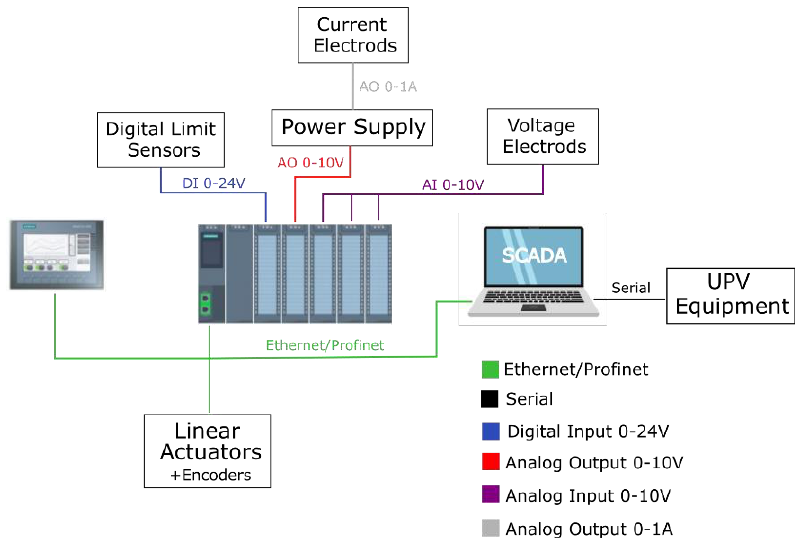
Figure 9. Prototype implementation (wiring diagram).